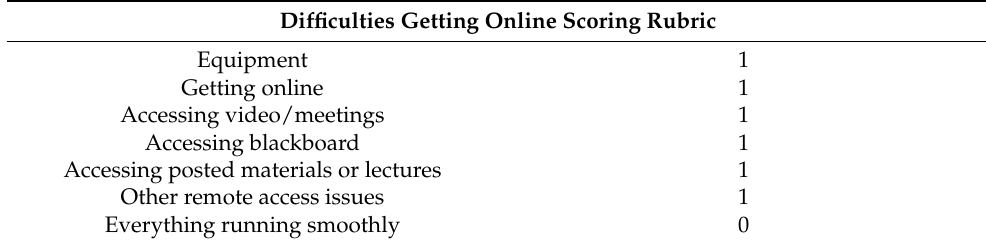
Table A4. Difficulties getting online assessment rubric for survey answers. Participants were told to select all that applied, and scores were cumulative based on their selections.